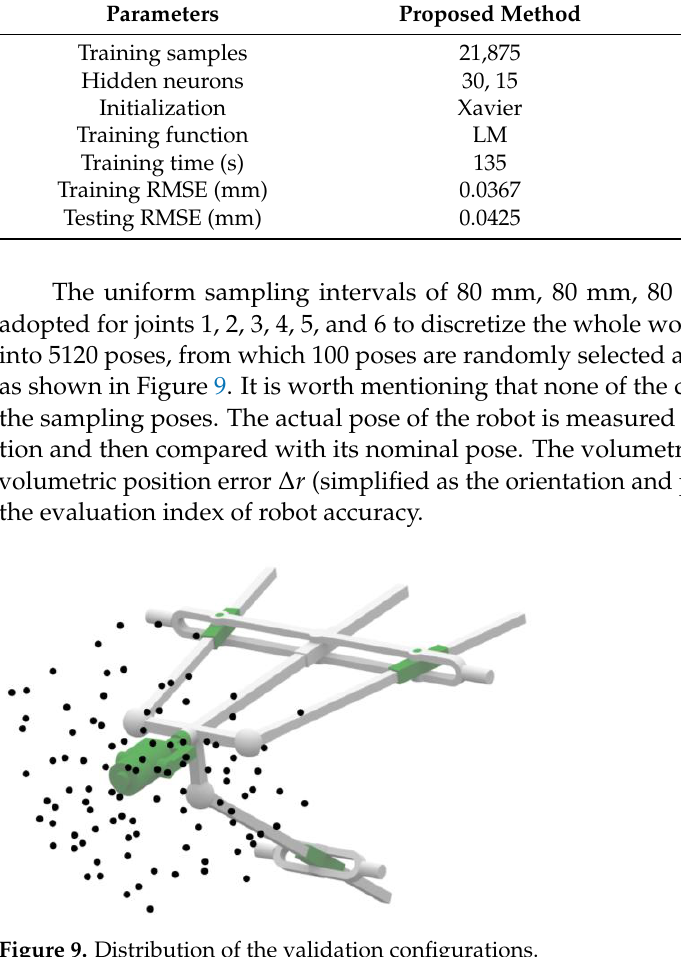
Figure 9. Distribution of the validation configurations.